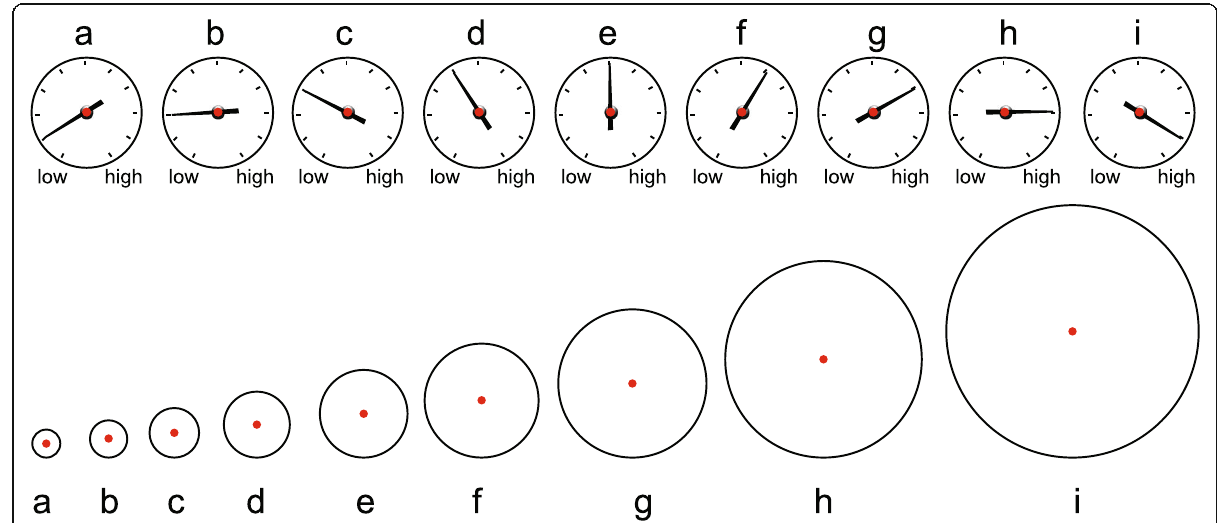
Fig. 4 An example of the visual depiction of the Likert scales, which depicts intensity with gauges (top) and size with the diameter of the circle